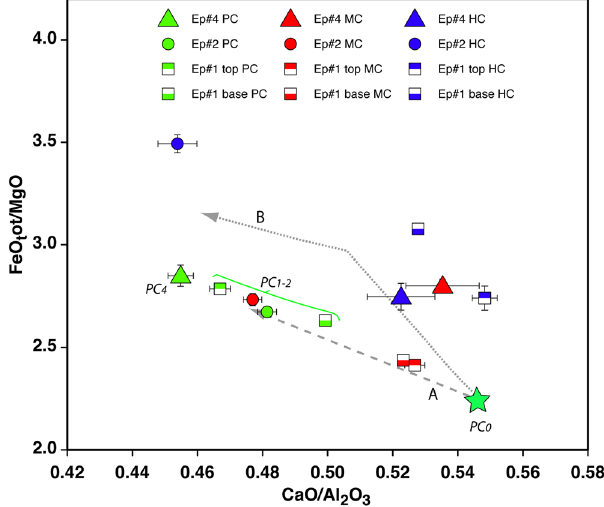
Figure 6. CaO/Al 2 O 3 vs FeO tot /MgO diagram reporting average groundmass composition for clasts of the same type with differing crystallinity (blue = highly crystalline, red = moderately crystalline; green = poorly crystalline) from distinct eruptive episodes. Error bars show standard error of the mean. The star represents the most primitive glass composition measured in a poorly crystalline clast from the base of episode #1. This is the starting composition used for alphaMELTS modelling 24, 25 . Line A represents the liquid line of descent during crystallization of plagioclase and clinopyroxene at 0.1 < P < 25 MPa for a cooling of 30 °C under f O 2 = NNO and = 0–1. Line B shows the liquid line of descent related to the crystallization of olivine, clinopyroxene and f H O 2 plagioclase at P = 0.1 MPa and T 1140–1110 °C and f O 2 = QFM and f refill different